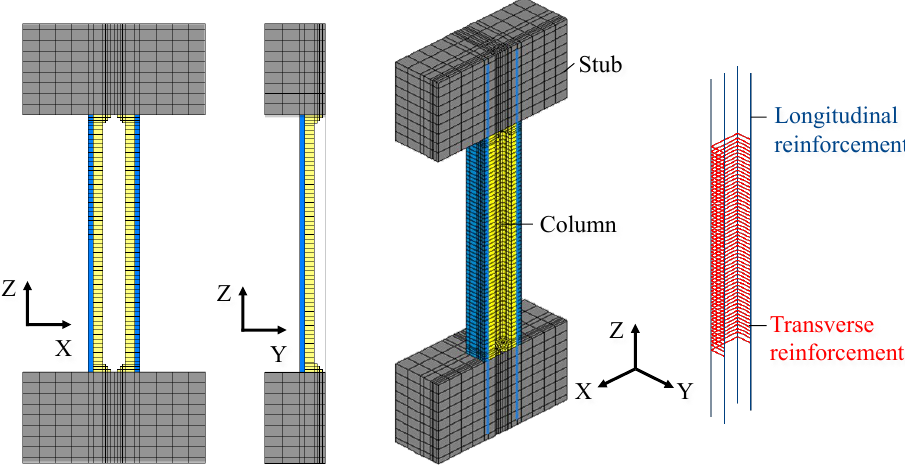
Figure 14. Geometry of Finite element model and meshing.